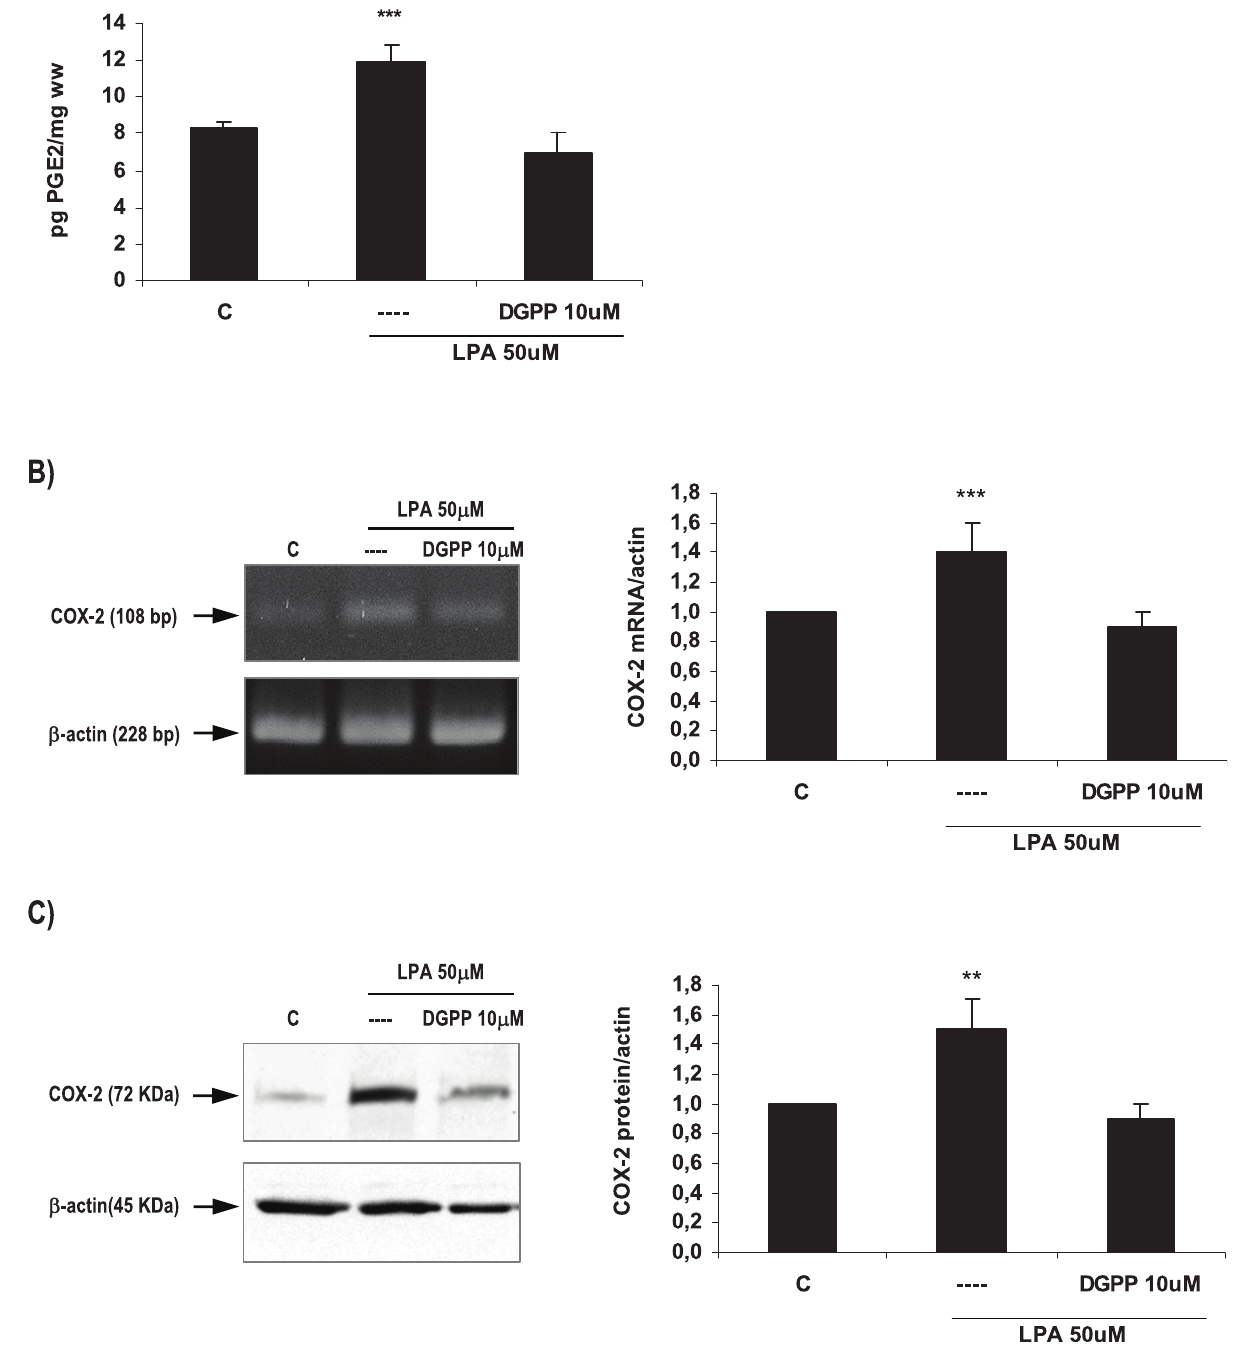
Figure 6. LPA3 mediated LPA effect on the production of PGE2 and on COX-2 expression in the rat uterus during the window of implantation. Uterine strips from rats pregnant on day 5 of gestation (implantation window) were incubated with LPA 50 m M for 6 h in the presence of DGPP 10 m M (a selective LPA3 antagonist) and the production of PGE2 (A) and the expression of COX-2 mRNA (B) and protein (C) were determined. In A and B: *** p , 0,001 vs the rest; In C: ** p , 0,01 vs the rest. Results are shown as means 6 sem. N=4–6 for each point. C: control. doi:10.1371/journal.pone.0046059.g006 a highly potent and selective antagonist for LPA3 receptor. We (Figure 3B) and FAAH protein level (Figure 3C). The incubation observed that the incubation with DGPP 10 m M blocked LPA with DGPP 10 m M alone did not regulate FAAH activity and effect on FAAH activity (Figure 3A), FAAH mRNA expression expression (Table 3). These results suggest that during the window